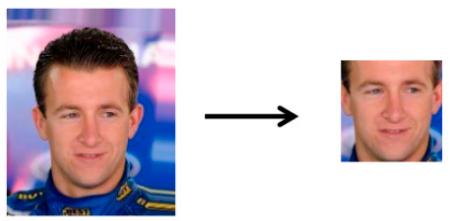
Figure 3. Face Figure 3. Face interception.